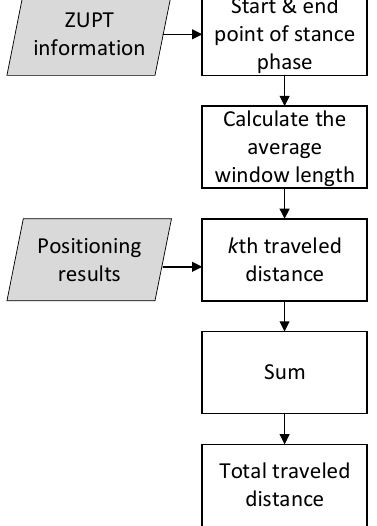
Figure 23. Flowchart of Figure23. Flowchart of ZUPT-AAWL.